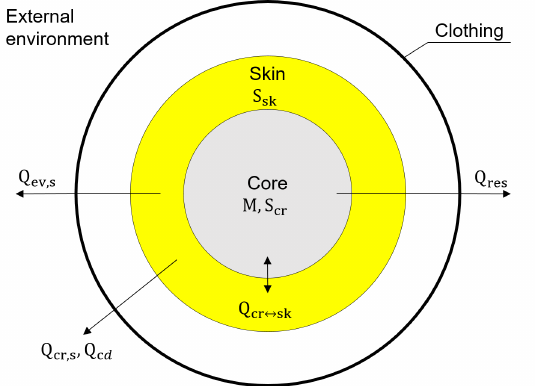
Figure A1. Graphic representation of the two-node model. The core and skin compartment are depicted as a grey and yellow disk, respectively, whereas the clothing is represented as a black